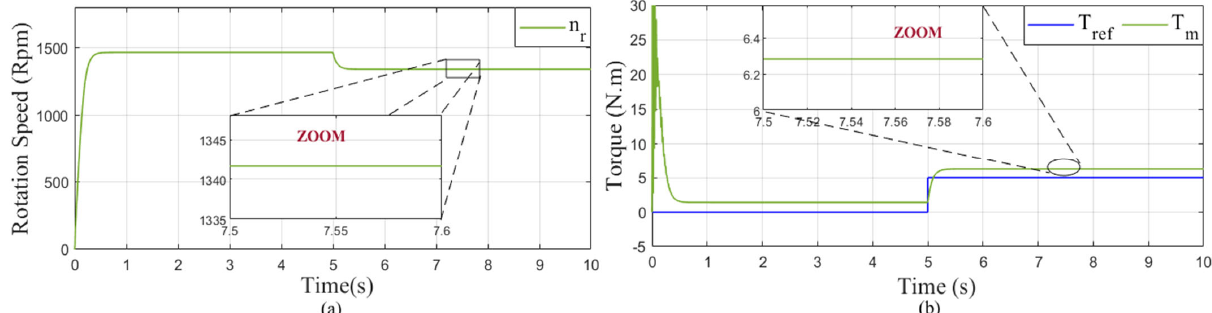
Figure 14. Performance in healthy state of IM without control: ( a ) rotation speed and ( b ) motor torque.